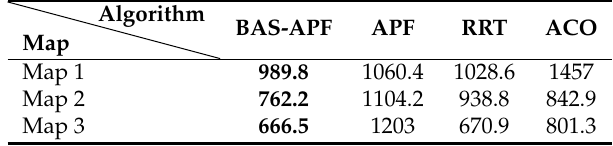
Table 1. Summary of comparison results of various algorithm path